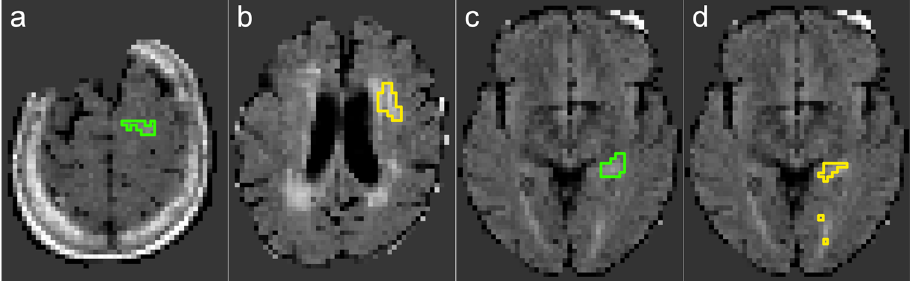
Fig 6. Worst two cases. See text for description. (a) 37/44 ground-truth (GTG). (b) 37/32 tunedET. (c) 44/24 ground-truth (GTG). (d) 44/24 CNN.